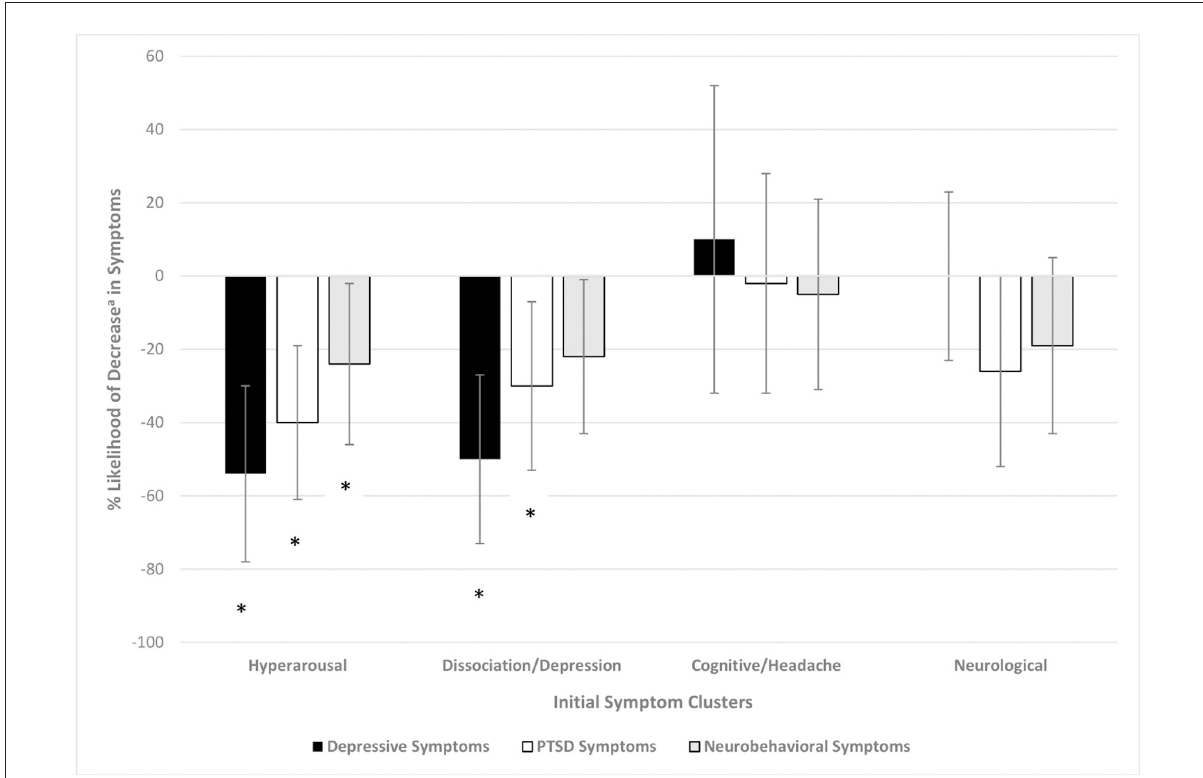
FIGURE3 Percent likelihood of clinically-relevant decrease a in outcome based on initial symptom cluster. Poisson regression with robust error variance, adjusted for the following by initial symptom cluster: hyperarousal: race, number of days in treatment, pre-treatment outcome level; dissociation/depression: race, number of days in treatment, pre-treatment outcome level; cognition/headache: number of days in treatment; and pre-treatment outcome level; neurological: pre-treatment outcome level. a Clinically-relevant decrease of 5 points for PHQ-8, 7 points for PCL-5 and 8 points for NSI. *Significant p -value at the level <